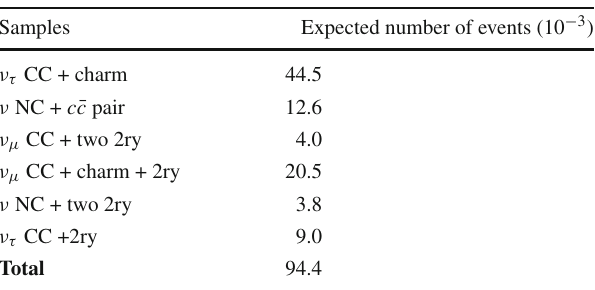
= 2 . 44 × 10 − 3 eV 2 , 32